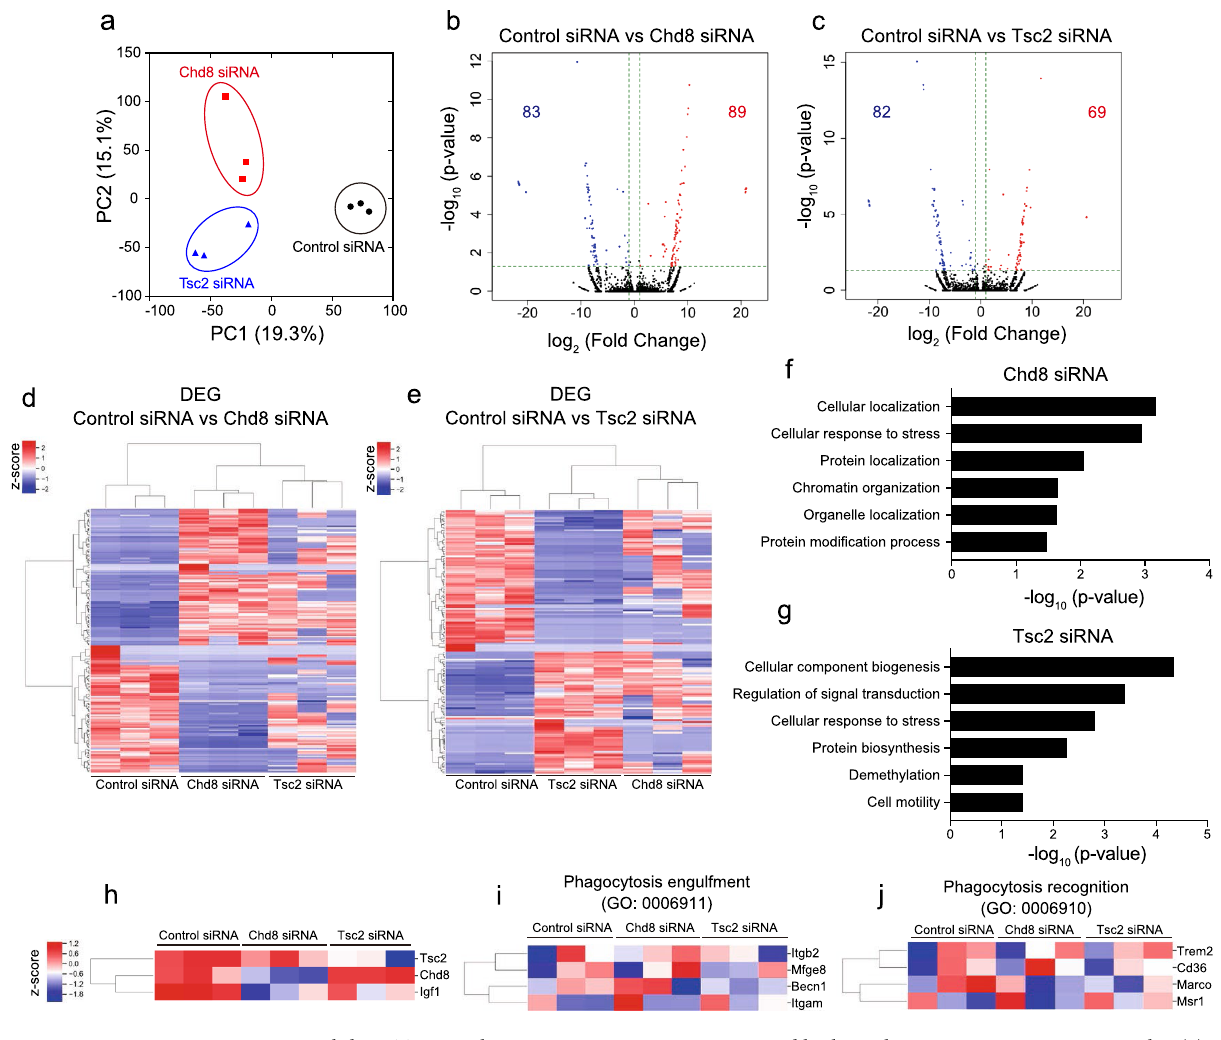
Figure 5. Chd8 or Tsc2 regulates numerous gene expression and biological processes in primary microglia. ( a ) PCA analysis showing gene expression variance from control siRNA (black, n = 3), Chd8 siRNA (red, n = 3), Tsc2 siRNA (blue, n = 3)-treated microglia. Percentages represent variance obtained by each principal component. ( b ) Volcano plot showing differentially expressed genes (DEGs) between control siRNA-treated microglia and Chd8 siRNA-treated microglia. ( c ) Volcano plot showing DEGs between control siRNA-treated microglia and Tsc2 siRNA-treated microglia. ( d ) Heatmap showing the expression of DEGs found between control siRNA and Chd8 siRNA-treated microglia. ( e ) Heatmap showing the expression of DEGs found between control siRNA and Tsc2 siRNA-treated microglia. ( f ) Graph showing the − log ( p -value) and GO terms enriched in the DEGs found between control siRNA and Chd8 siRNA. ( g ) Graph showing the − log ( p -value) and GO terms enriched in the DEGs found between control siRNA and Tsc2 siRNA. ( h ) Heatmap showing Tsc2, Chd8, and Igf1 expression in each siRNA treated microglia. ( i ) Heatmap showing the expression of phagocytosis engulfment-related genes. ( j ) Heatmap showing the expression of phagocytosis recognition-related DMEM containing 10% FBS, and filtered with 70 μm nylon cell strainer. Cells were plated on poly-l-lysine pre- coated 75 cm 2 tissue culture flask (IWAKI) in DMEM supplemented with 10% FBS and penicillin–streptomycin (Thermo Fisher Scientific). After 12–15 days, culture flasks were gently shaking for 30 min, and supernatant was centrifuged at 1500 rpm for 10 min. The cell pellet was resuspended with microglia culture medium sup- plemented with 50% of the supernatant, 10% FBS in DMEM, and plated to 96 well plate. Each biological replicate represents a culture prepared from a distinct mouse brain. All experiments were repeated at least three times. For primary OPCs, mixed glial cells with removed microglia were detached from the culture flask by treat- ment with 0.05% trypsin for 5 min and replated to fresh culture flasks. After 30 min of incubation, the culture medium was centrifuged at 500× g , and the cell pellet was resuspended in OPC culture medium supplemented with sodium pyruvate (1:100, Gibco), apo-transferrin (50 μg/mL, Sigma-Aldrich), bovine serum albumin (0.1%, Sigma-Aldrich), insulin (5 μg/mL, Sigma-Aldrich), biotin (10 nM, Sigma-Aldrich), hydrocortisone (10 nM, Sigma-Aldrich), sodium selenite (30 nM, Sigma-Aldrich), and penicillin–streptomycin (1:100, Life Technolo- gies). OPCs were plated onto poly-l-lysine-coated 96 well plates.